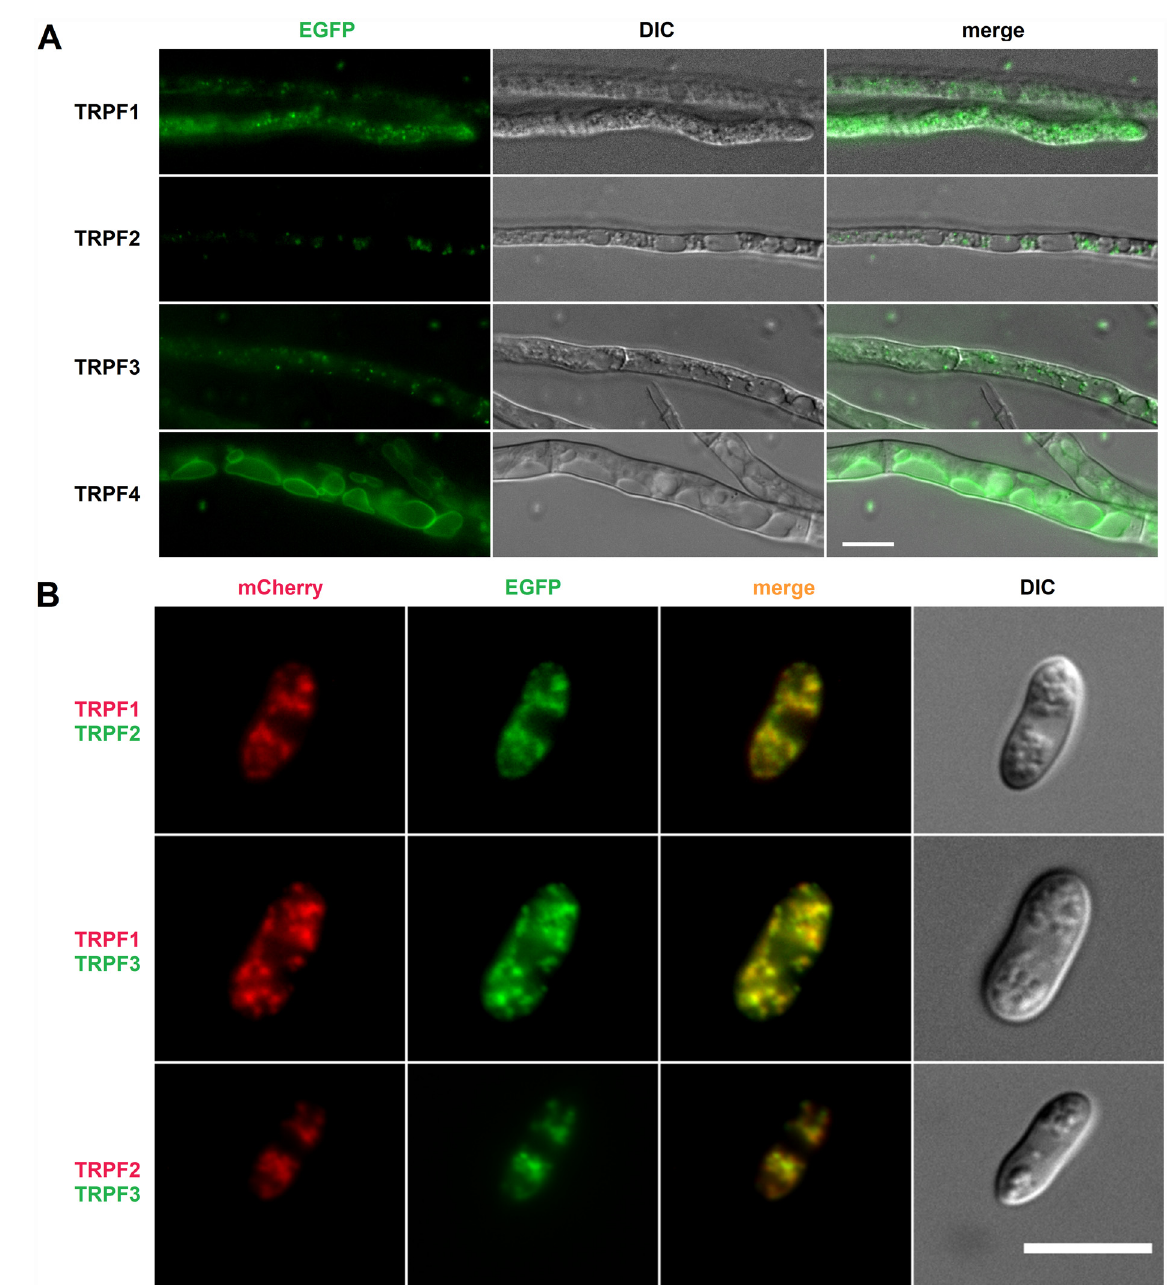
Fig 4. Sub-cellular localization of Colletotrichum graminicola TRPF proteins. (A) Hyphae expressing CgTRPF1 through 4 fused to EGFPf driven by the respective native CgTRPF promoters. (B) Co-localisation of CgTRPF1 through 3 with each other. Oval conidia expressing CgTRPF1 through 3 genetically fused to mCherry and EGFPf driven by the respective native CgTRPF promoters. Each strain was transformed with a mCherry- tagged CgTRPF gene and another EGFPf -tagged CgTRPF gene. Upper panel: CgTRPF1-mCherry and CgTRPF2-EGFPf , middle panel: CgTRPF1-mCherry and CgTRPF3-EGFPf , bottom panel: CgTRPF2-mCherry and CgTRPF3-EGFPf . Bars: 10 μ m.